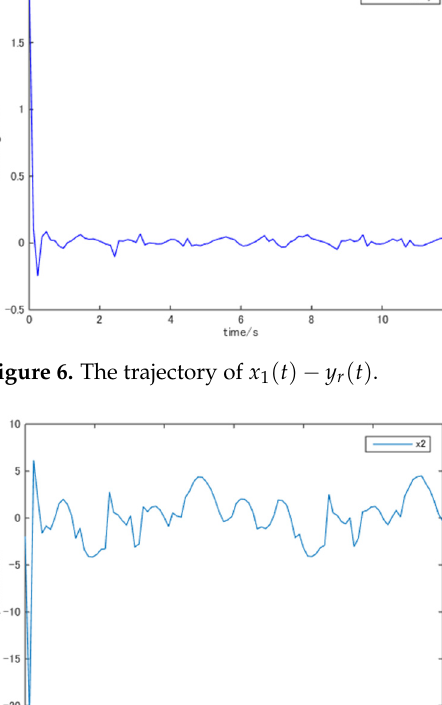
y t . Figure 5. The trajectories of x 1 ( t ) and y r ( t ) . r